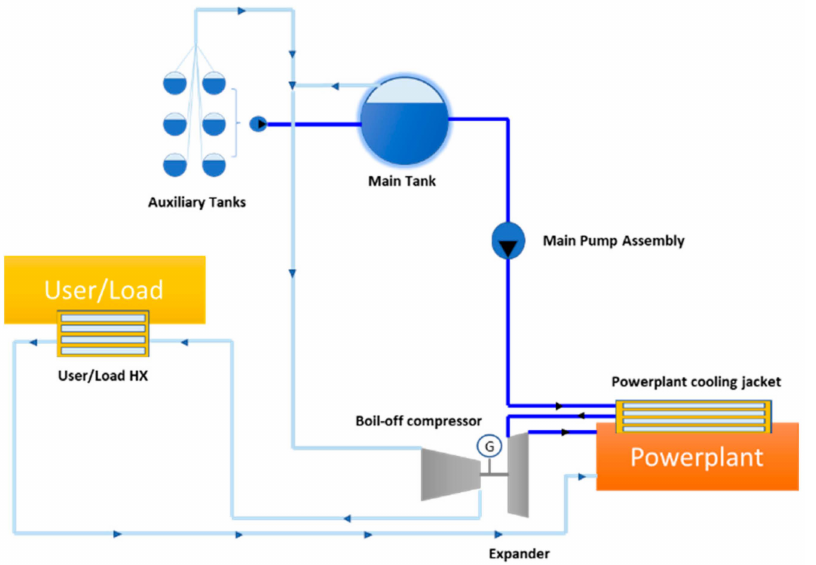
Figure 6. STRATOFLY MR3 thermal management system architecture